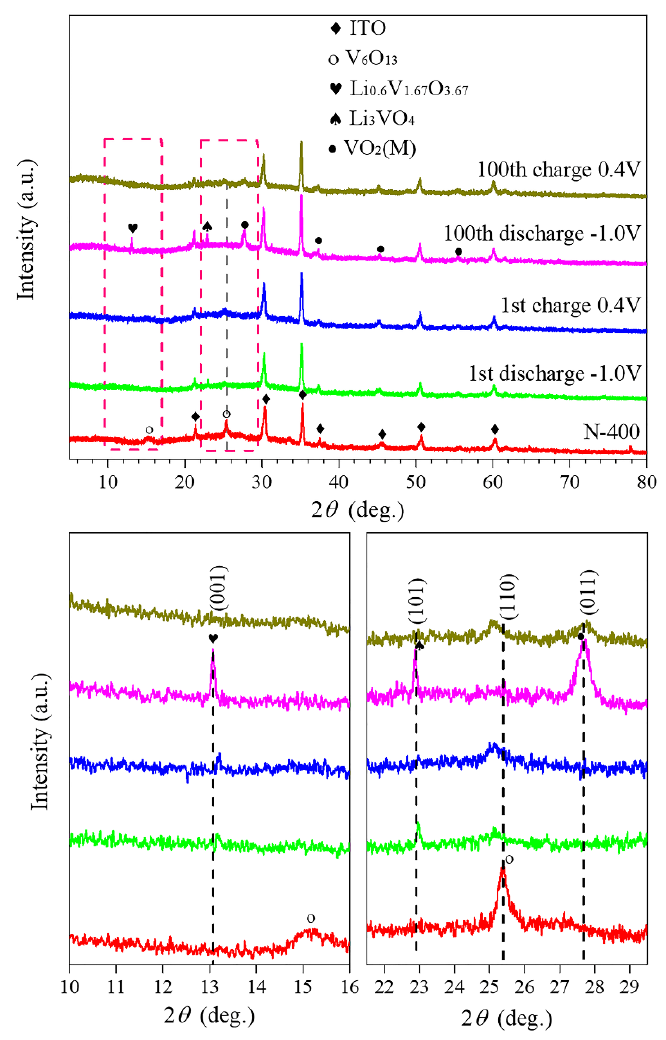
Figure 10. Ex-situ XRD patterns of the N − 400 film.